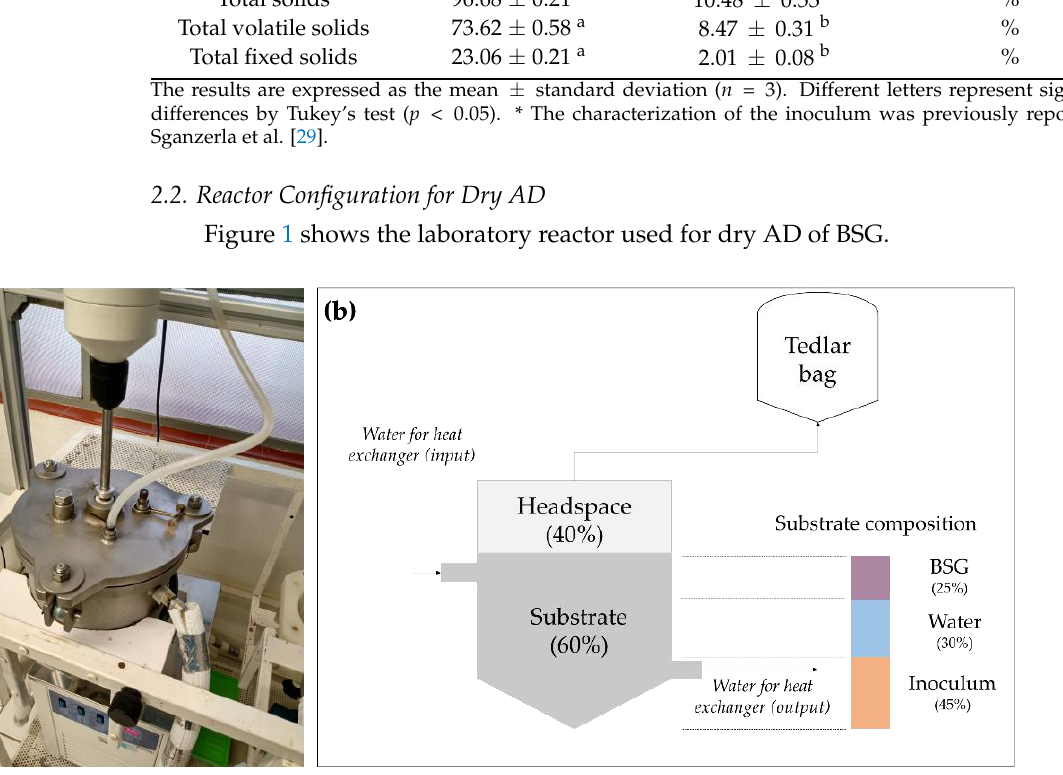
Figure 1. Representation of the laboratory reactor for dry AD of BSG. ( a ) Laboratory reactor; ( b ) description of the reactor configuration. Adapted from Sganzerla et al. [29], with permission from Springer Nature.